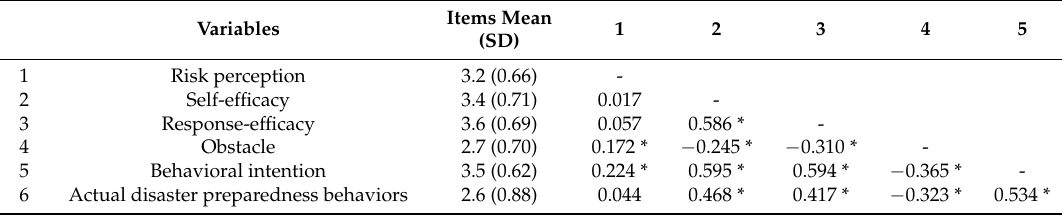
Table 2. Means, standard deviations, and correlations of variables ( n = 286).